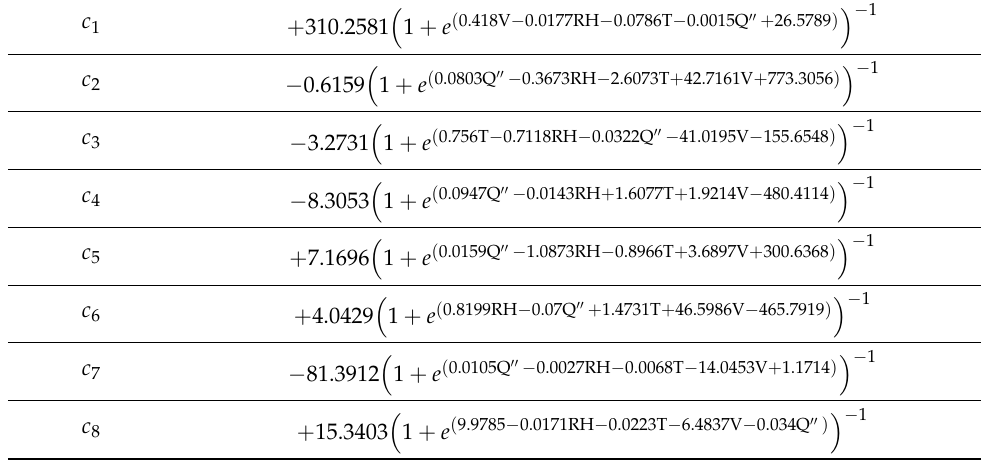
Table 1. The coefficients for calculating the ECI max